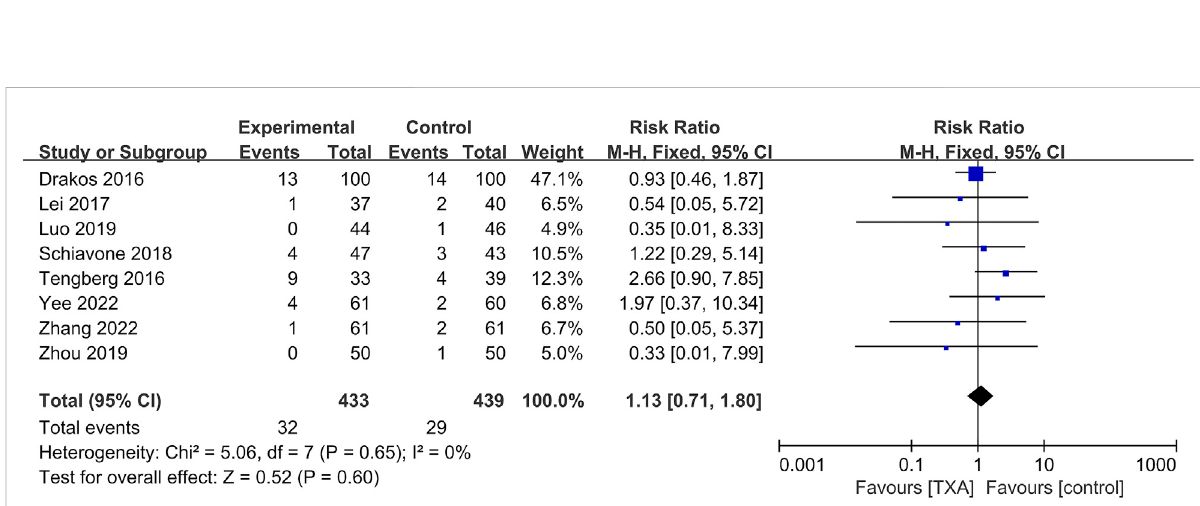
FIGURE 8 Forest plot showing the mortality within 1 year of TXA group vs. control